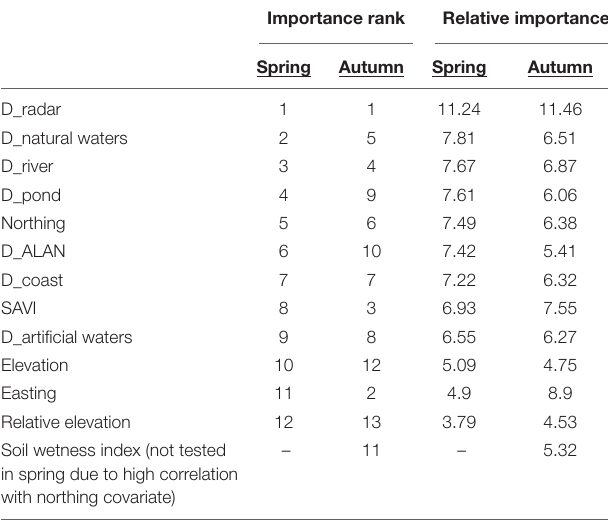
TABLE 2 | Top 13 influencing covariates in the spring and the autumn as found in Boosted Regression Tree models. Relative importance of covariates is based on the number of times a variable is selected for splitting, weighted by the squared improvement of the model, averaged over all trees and scaled so that the sum adds to 100 (Friedman and Meulman, 2003). Covariate descriptions are given in Table 1